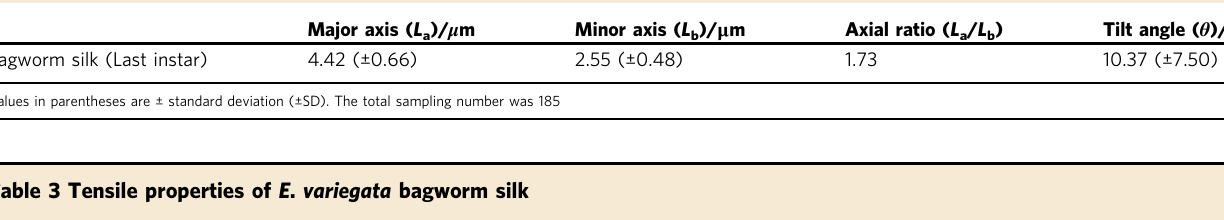
Table 2 Parameters of fi bre morphology of E . variegata bagworm silk